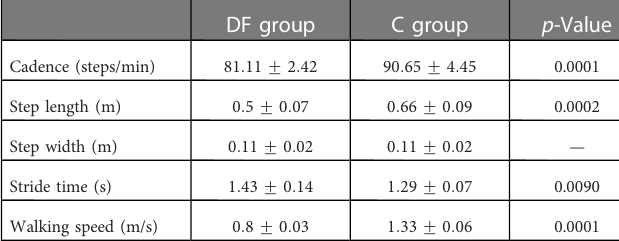
TABLE 1 Spatiotemporal gait patterns mean ( + standard deviation) in drop foot (DF) and Control (C) groups.